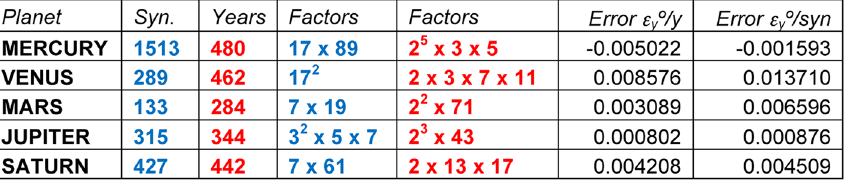
Figure 2. Finding period relations. Blue numbers refer to synodic cycles; red numbers refer to years. All the seed periods for these processes are known from Babylonian astronomy (Supplementary Tables S5, S6). ( a ) Linear combinations of Babylonian period relations, which give those for Venus and Saturn from the FCI. ( b ) Period relations generated by a conventional Parmenides Process , which also give those for Venus and Saturn from the FCI. ( c ) Iterations of an Unconstrained Parmenides Process . (2p + 2r, 2q + 2 s) is omitted from Iteration 3 because it is the same as 2 x (p + r, q + s). ( d ) Three iterations of the Unconstrained Parmenides Process . The pairs in colour are those that are factorizable with prime factors < 100. The grey-shaded periods are those that are known from the FCI. Note that for Venus: ( 1445 , 2310 ) ≡ ( 289 , 462 ) and ( 735 , 1175 ) ≡ ( 147 , 235 ). The same table with errors is shown in Supplementary Table S5. ( e ) Periods derived from the Unconstrained Parmenides Process for our model of the Antikythera Mechanism and their errors, using our three criteria of accuracy , factorizability and economy . Except for the periods for Venus and Saturn, all the final periods were already known in Babylonian astronomy. The error parameters are defined in Supplementary Discussion